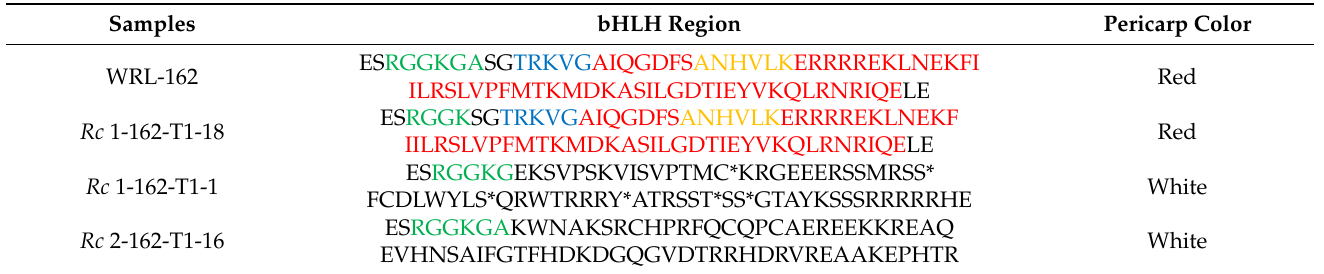
Table 2. Predicted amino acid sequence analysis of Rc mutants of weedy rice using 5 kinds of Rc/rc alleles as control.